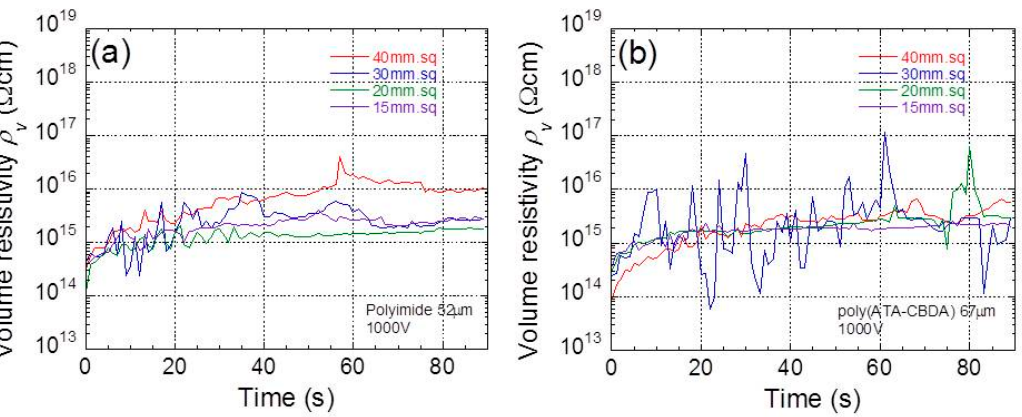
Figure 2. Time profiles of electric resistivity at 1000 V for ( a ) polyimide and ( b ) biopolyimide films with various film sizes.